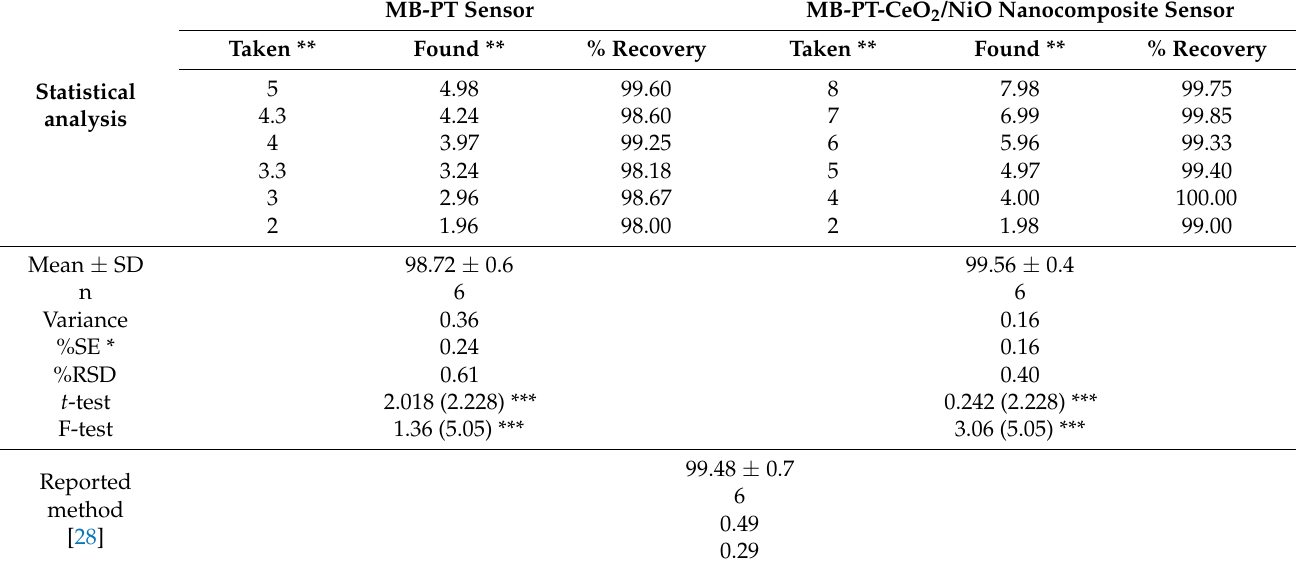
Table 6. Detection results of Duspatalin ® 200 mg/capsule using the MB-PT and MB-PT-CeO 2 /NiO nanocomposite sensors.